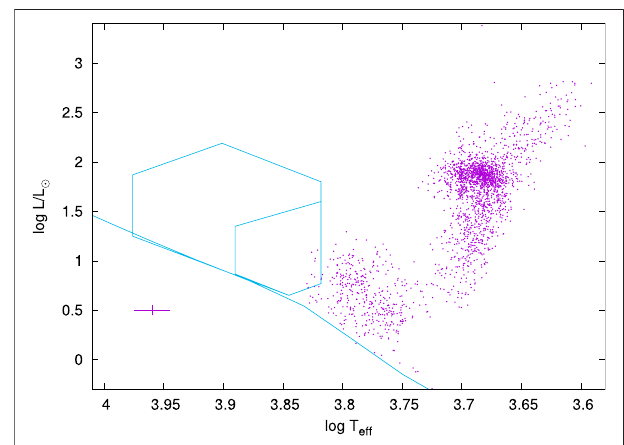
FIGURE 1 | The location of stars with solar-like oscillations from Huber et al. (2017) in the H-R diagram. The zero-age main sequence for models of solar abundance from Bertelli et al. (2008) is shown (solid line). The large polygonal region shows the location of δ Sct stars from Balona (2018). Thesmallerpolygonshowsthelocationofthe c Dorstars.Thecrossatbottom left indicates 1 − σ error bars in effective temperature and